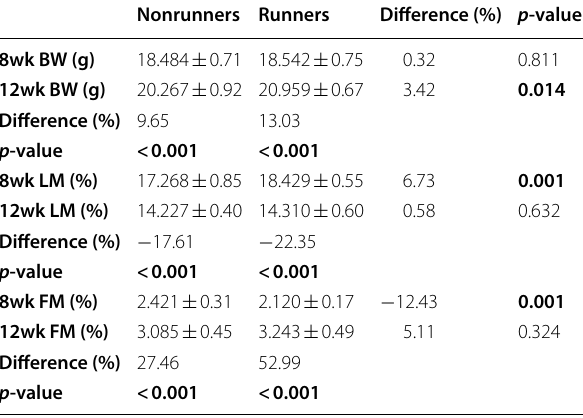
Table 2 Least square means differences in overall body composition between B6 runners and nonrunners